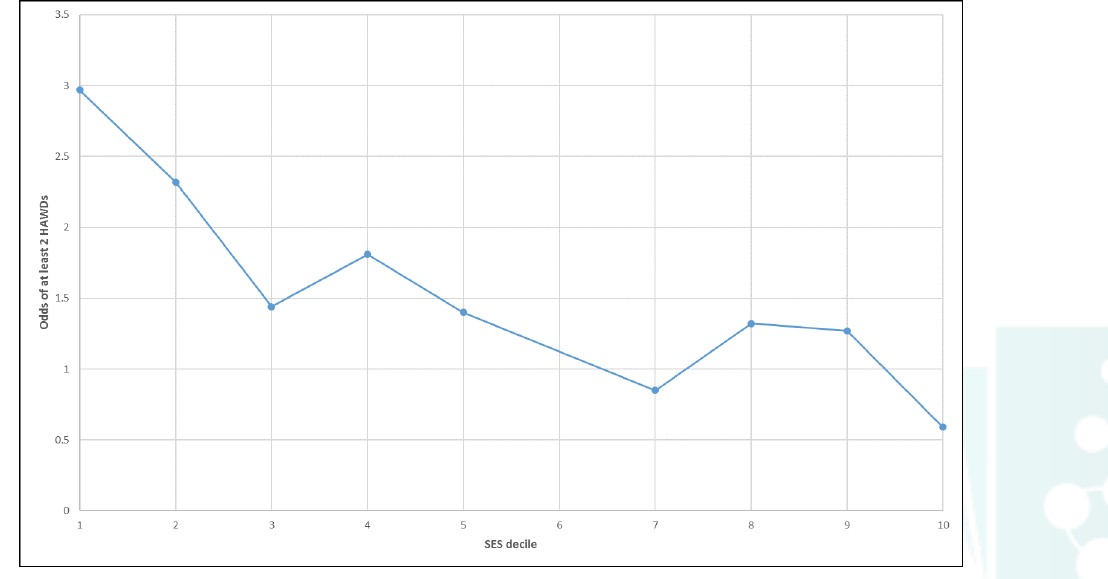
HAWD, Medical or psychiatric hospitalization associated with depression; SES, socio-economic status. Note: Unadjusted odds have been